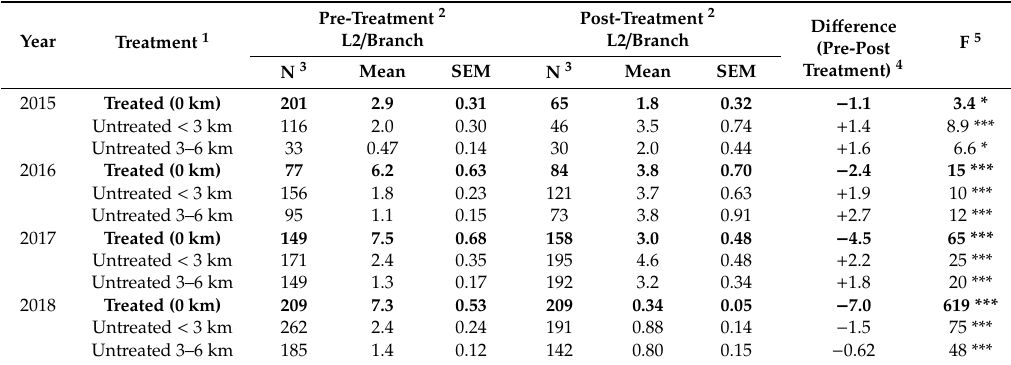
Table 3. Mean and standard error (SEM) number of SBW second instar larvae (L2) per branch from samples taken before and after budworm protection treatment, each year from 2015–2018, comparing treated samples with untreated samples within 3 km and 3–6 km adjacent to treated blocks. Treated values are shown in bold and % di ff erence from pre- to post-treatment is